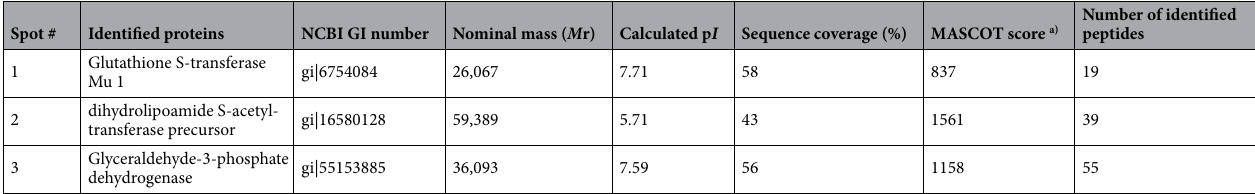
Table 1. mRib72 immunoreactive proteins were not myoclonin1 isoforms. a MASCOT score is defined as − 10 × Log( P ), where P is the probability that the observed match is a random event. Scores greater than 67 are significant ( p <